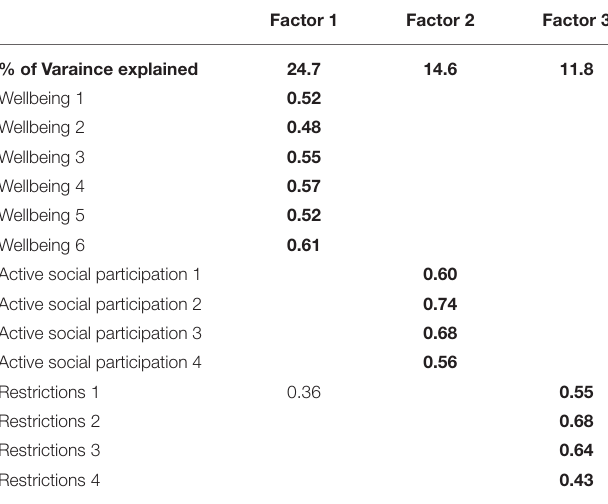
TABLE 2 | Factor loadings of the final items included in the